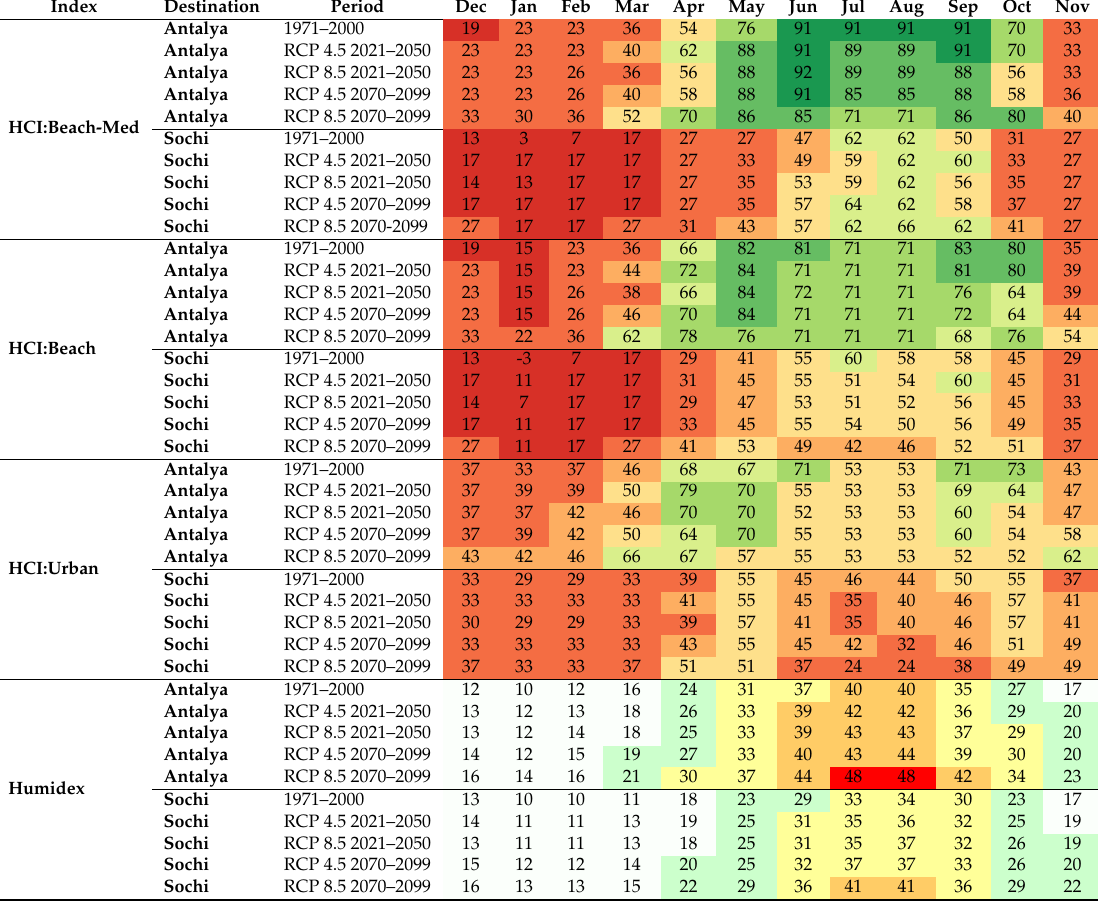
Table 6. A Comparison of Projected HCI Scores and Humidex Risks of Antalya and Sochi.